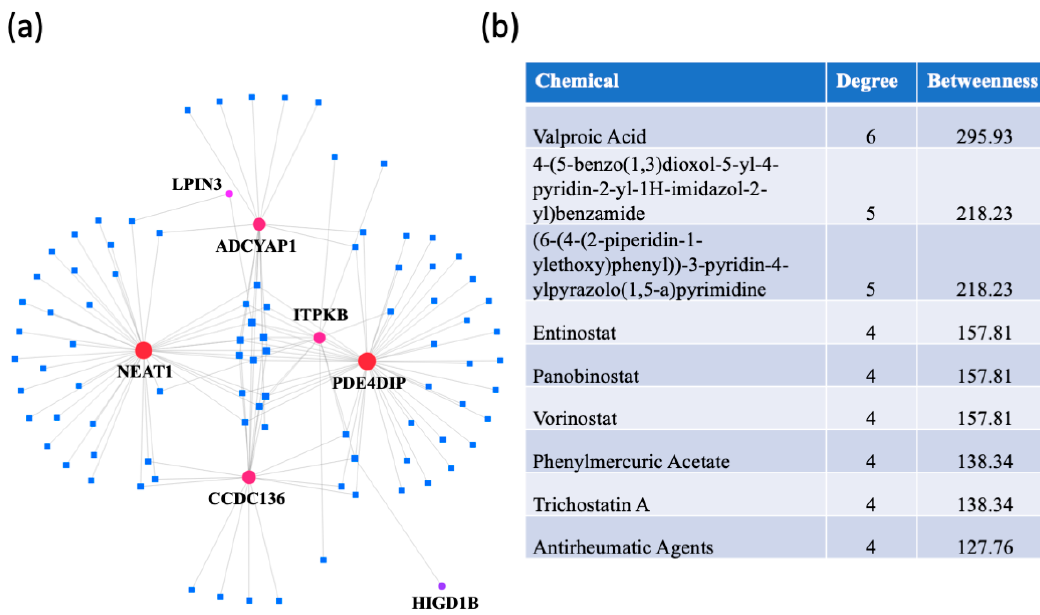
Figure 8. Protein-chemical interaction analysis. NetworkAnalyst was used to identify potential therapeutic reagents. ( a ) A protein-chemical network was created using the data from the Comparative Toxicogenomics Database (CTD). The dementia switch genes are represented by the red dots and the drugs are represented by blue squares. ( b ) List of the highest ranked chemicals, with a degree ≥ 4.